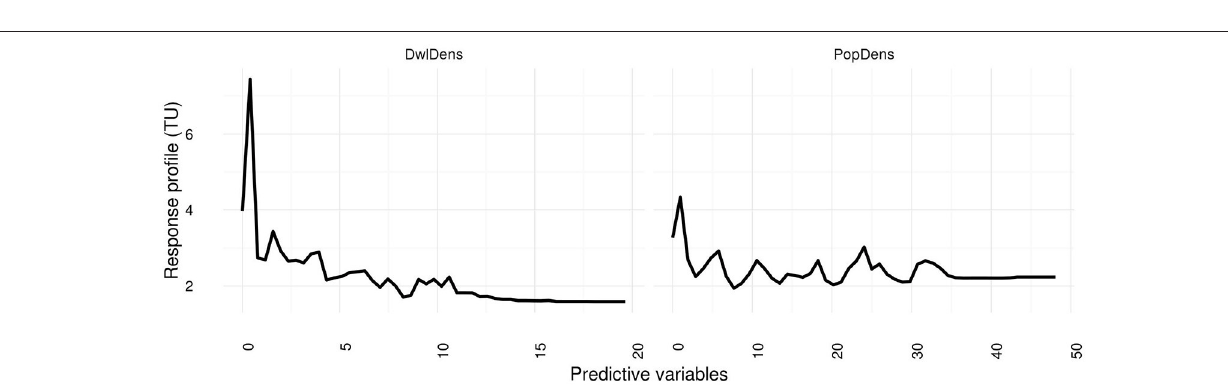
FIGURE 5 | Modeled partial dependence of bifenthrin toxic units (TU) on selected predictor variables. Marginal response is shaded in proportion to the change in MSE in the final bifenthrin model, hence darker shading indicates more important